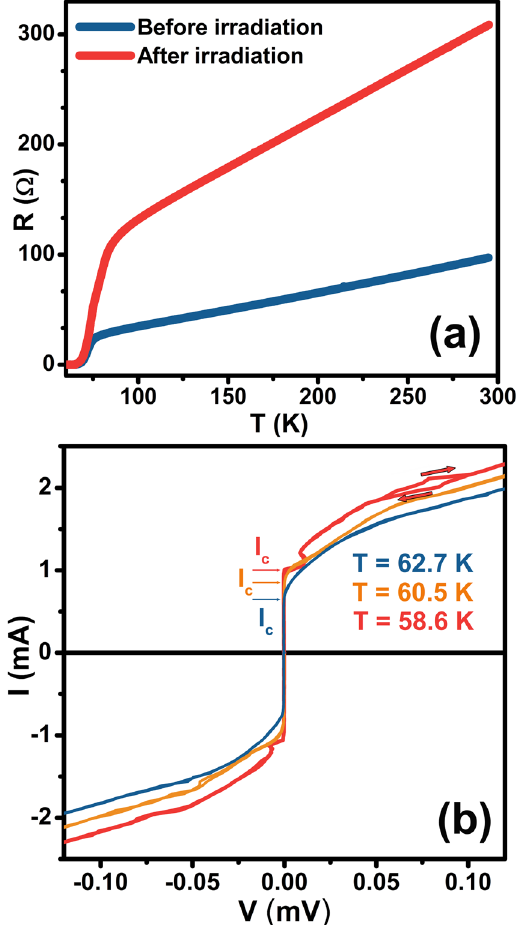
Figure 4. ( a ) Comparison of resistance versus temperature measured in the four-probe configuration between pristine (blue curve) and patterned (red curve) conditions. ( b ) I–V characteristics of a patterned device measured at 58.6 K (red curve), 60.5 K (orange curve) and 62.7 K (blue curve). The red arrows highlight the typical hysteretic pattern in the case of T = 58.6 K. The maximum current amplitudes I c for the three different temperatures are also